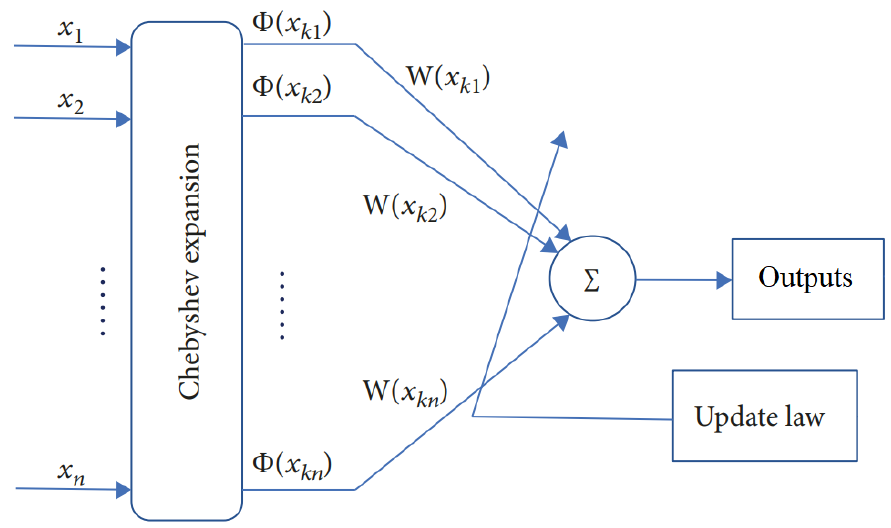
Figure 4. The ChNN structure.